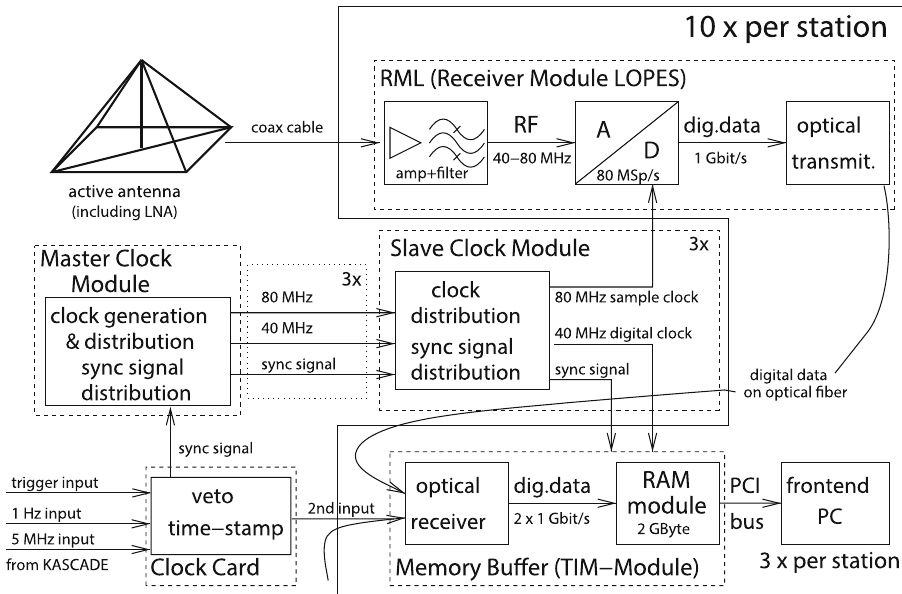
Fig. 4 Data-acquisition system (DAQ) of LOPES organized in three stations of 10 channels, each. The signal of all antennas was digitized continuously in ring buffers. After receiving an external trigger, the signal of all 30 antennas were read out simultaneously and stored on one of nine local computers. Then, the data were combined to one event in a central computer and stored on a hard disk and as backup additionally on